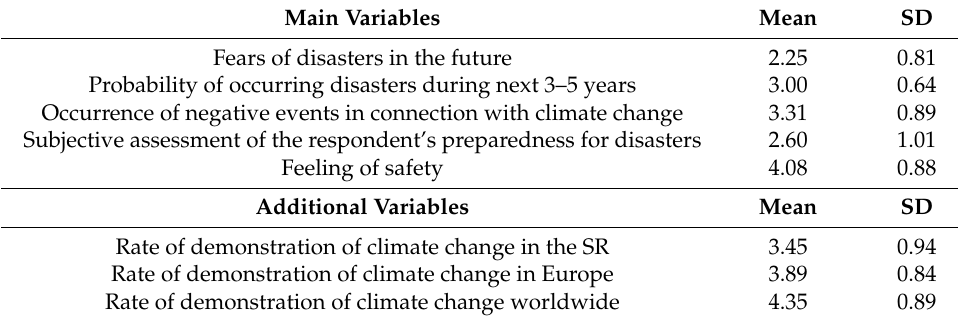
Table 3. Main and additional variables concerning the risk perception.